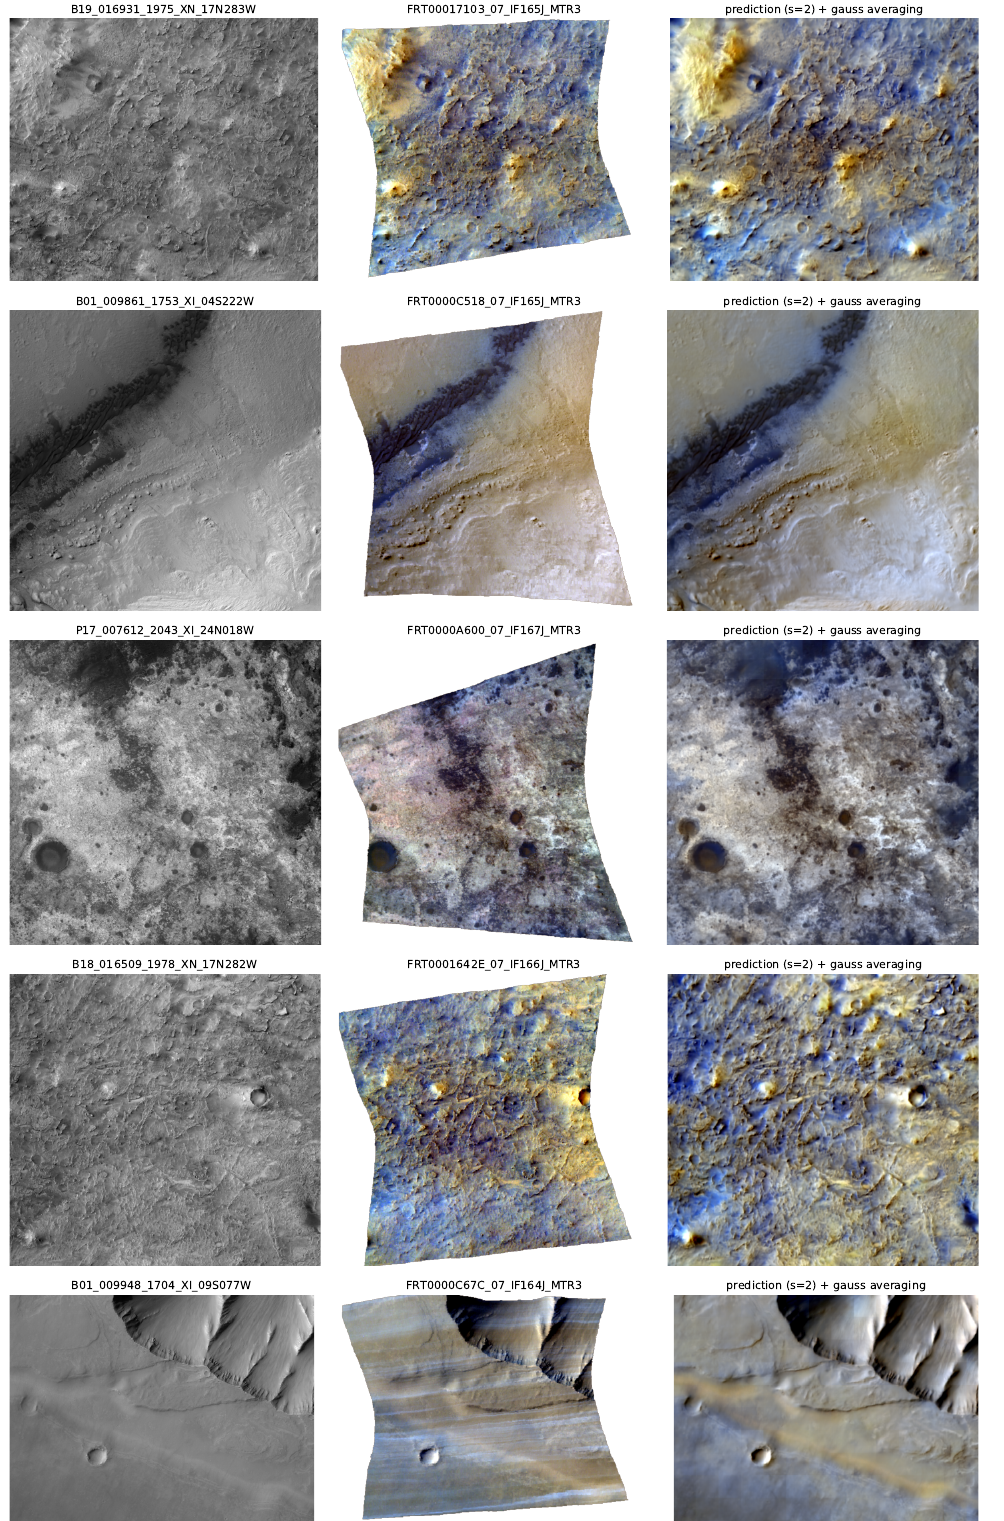
Figure 20. Full EVC image predictions of the proposed approach. From top to bottom: Jezero crater training CTX-CRISM pair, Gale crater training CTX-CRISM pair, Mawrth Vallis training CTX-CRISM pair, Jezero crater validation CTX-CRISM pair, and Melas Chasma CTX-CRISM pair excluded from training with stripe artifacts spanning the entire CRISM